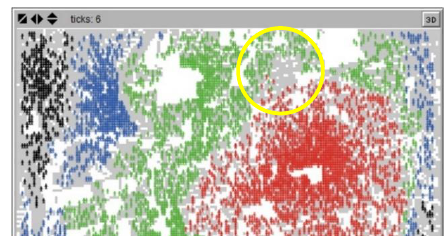
Figure 5: Initial phase of the model